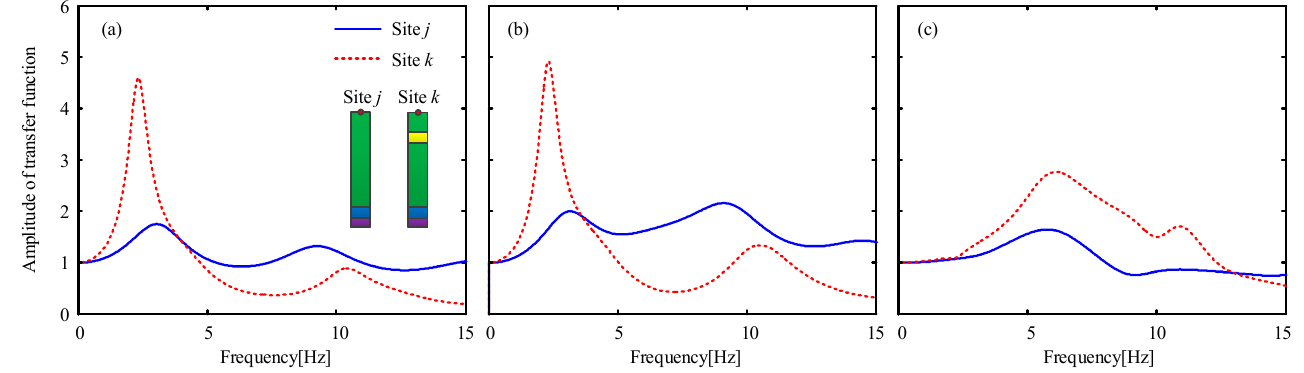
Figure 2. Transfer functions at sites j and k for: ( a ) horizontal out-of-plane motion; ( b ) horizontal in-plane motion; and ( c ) vertical in-plane motion when Cs SI = 100 m/s, D SI = 5 m, and H SI = 5 m.